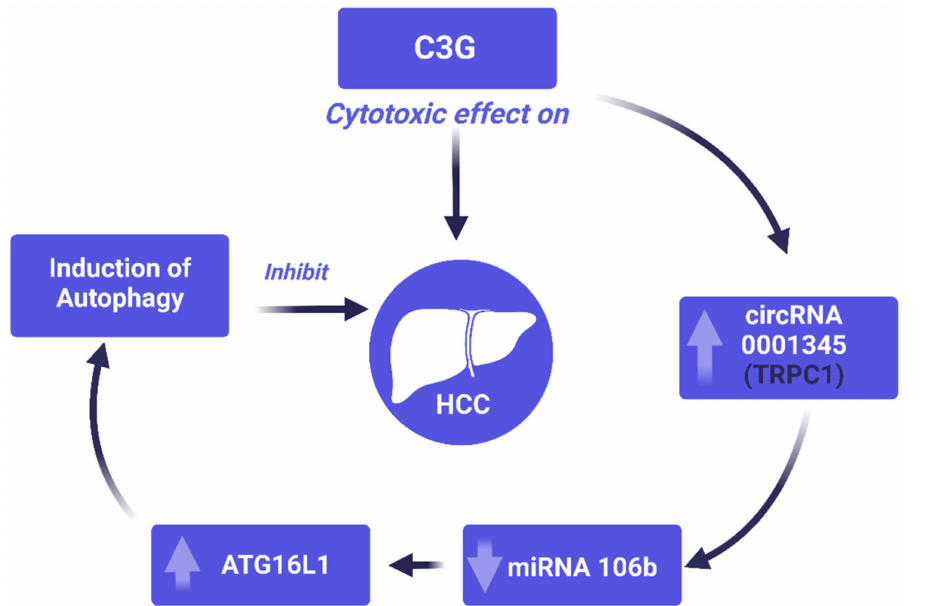
Figure 1. A schematic representation of the proposed pathway for the anticancer effect of C3G on modulating (circRNA0001345/miRNA106b/ATG16L1)